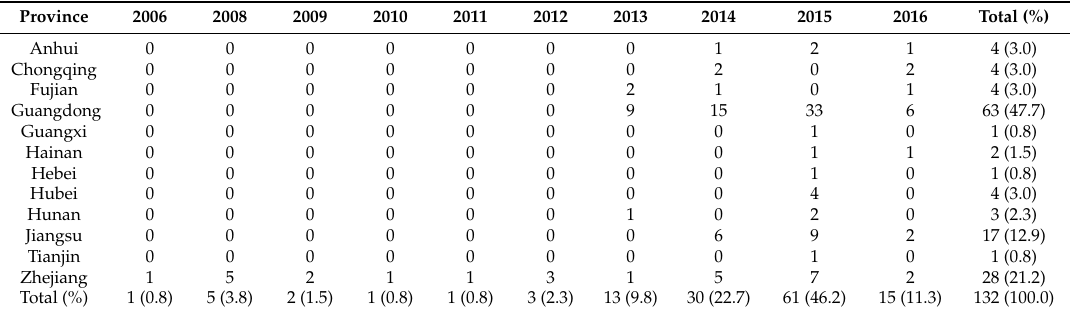
Table 1. The number of acute gastroenteritis outbreaks associated with noroviruses reported in 12/31 provinces of China from 2006 to